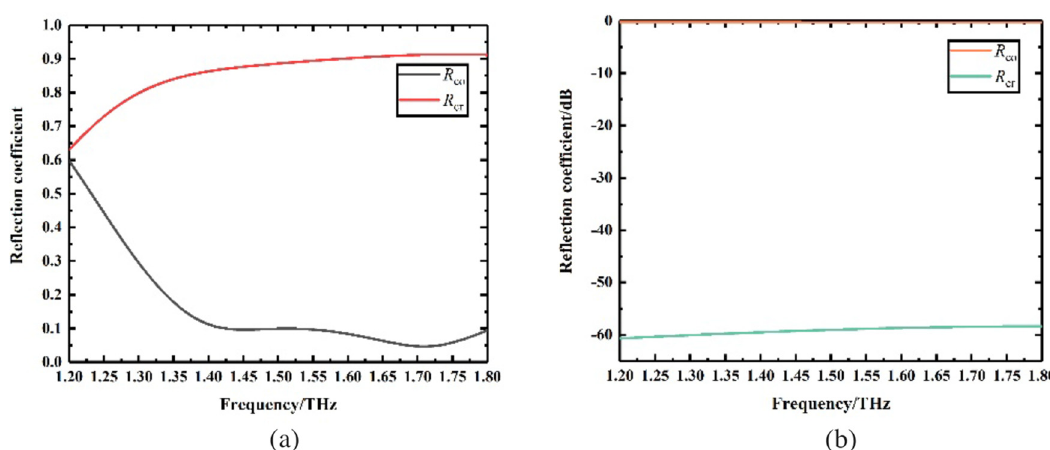
Fig. 2. The re fl ective characteristics of unit cell when (a) m c = 0.85 e V, (b) m c = 0 e